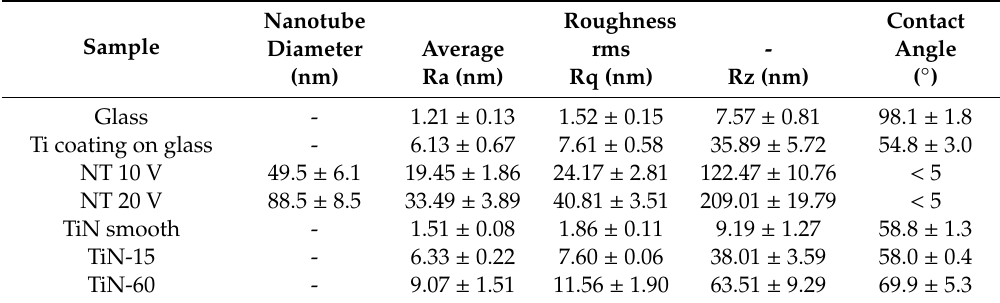
Table 2. Physical properties of the glass substrate, untreated Ti layer and the nanotubular surfaces, as well as the smooth and nanorough TiN